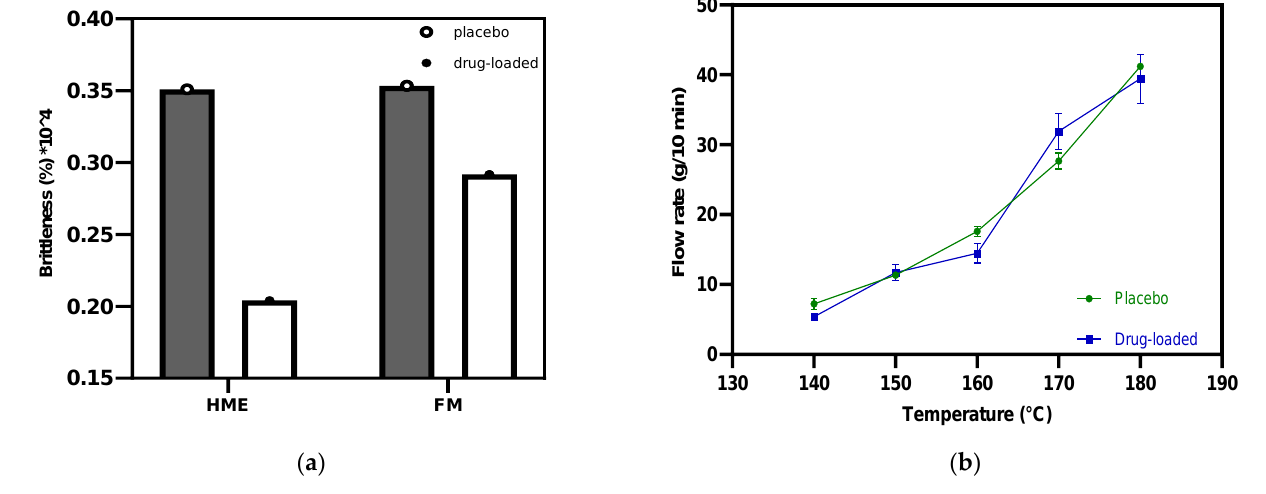
Figure 6. ( a ) Filament brittleness values were obtained from hot-melt extrusion and filament making processes; ( b ) the flow properties of placebo and drug-loaded filaments.